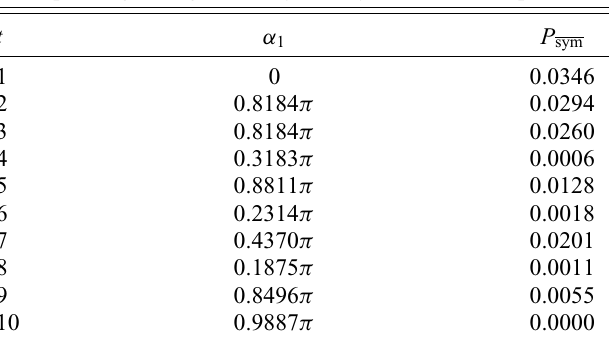
TABLE II. The values of α 1 used for the symmetry-protected XYZ ordering in Fig. 3 at different times t , together with the corresponding leakage to the symmetry-forbidden subspace.